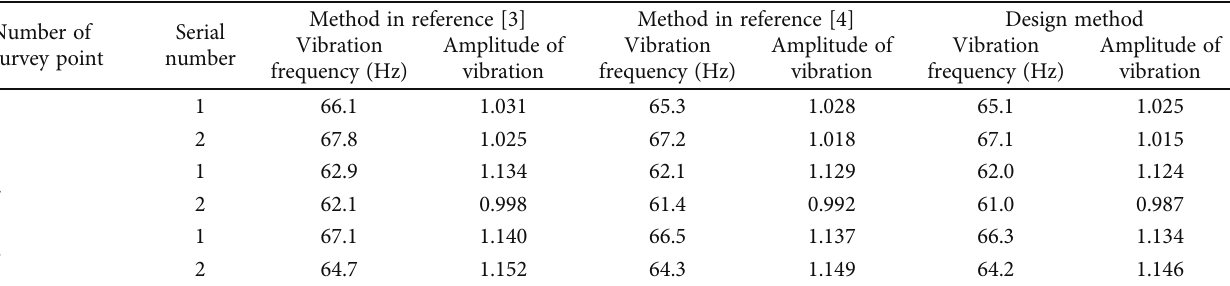
Table 4: Experimental results of vibration control for steel structures.